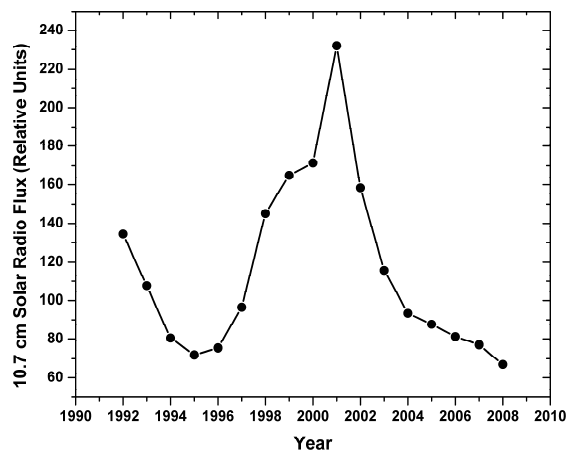
Fig. 12. Solar 10.7cm radio flux in relative units: points are means of daily measured values for each 30–35 day solstice